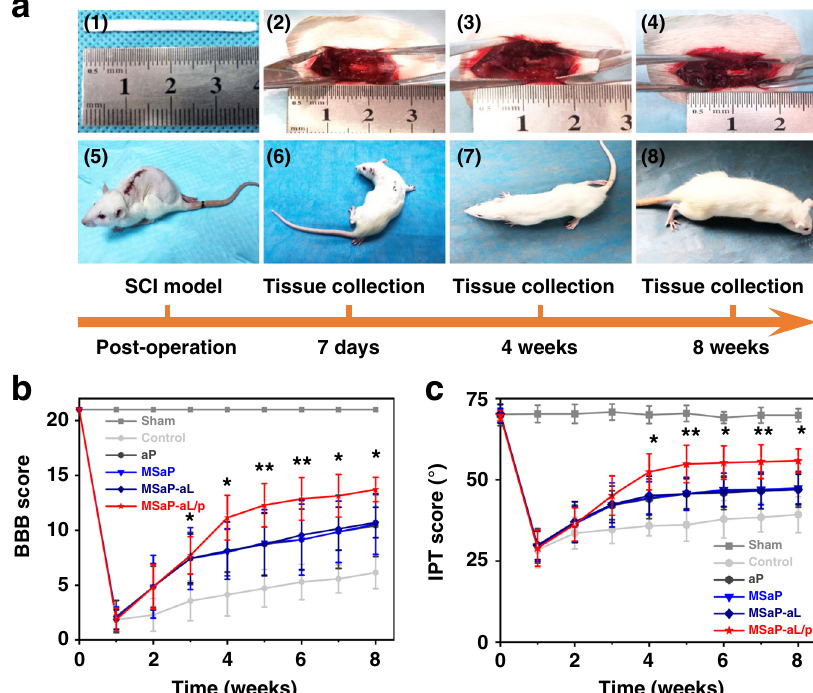
Fig. 8 Timeline of animal assay and motor function score. a Pictures of animal experiments and tissue collection timeline. Image of (1) the responsive fi ber bundle, (2) the fully exposed T9 spinal cord, (3) 3 mm hemi-section made in the right site of the T9 spinal cord (the yellow arrow indicated the injured site), (4) implanted fi ber bundles (the yellow arrow indicated the fi ber bundle implantation position) along with (5), (6), (7), (8) post-operation condition of rat at 7 days, 4 weeks, and 8 weeks (3 independent experiments). b Evaluation of motor function recovery of lower limb by BBB score in rats assisted by c rats ’ motor function IPT score ( n = 7, all values were mean ± std. dev., * p < 0.05, ** p < 0.01 when comparing MSaP-aL/p and other spinal cord injury groups at the same time point via two-way analysis of variance (ANOVA) with Tukey ’ s post hoc